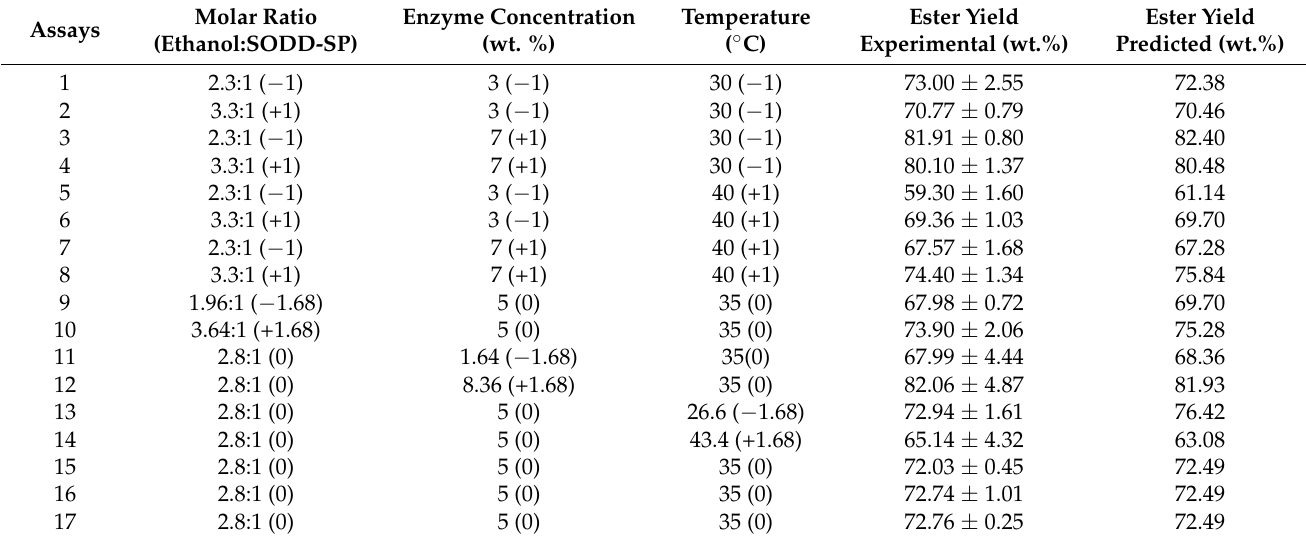
Table 2. Experimental design for the influences of three independent variables (real and coded) on the ester yield of the esterification/transesterification reaction with SODD saponifiable phase (SODD-SP) (experimental and predicted values). Assays